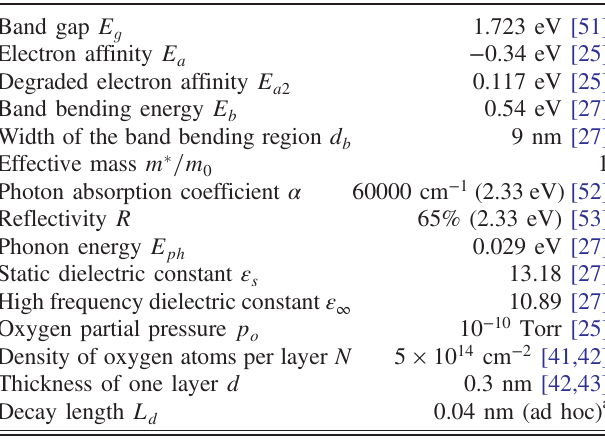
TABLE II. Parameter used for the case of GaAsP. Band gap E g